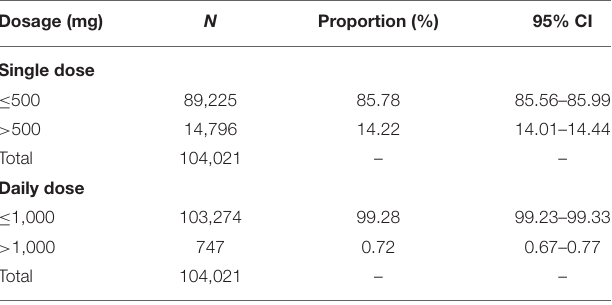
TABLE 4 | Proportions of IV ribavirin prescriptions in different